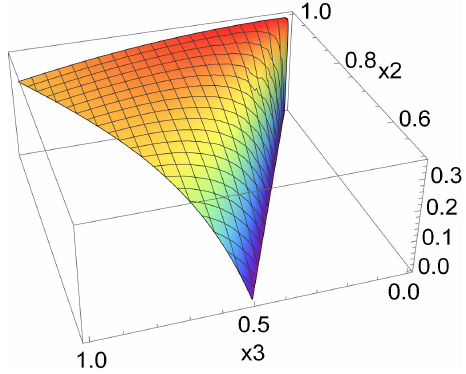
Figure 4. The shape of the unique parity odd, manifestly local B 00+